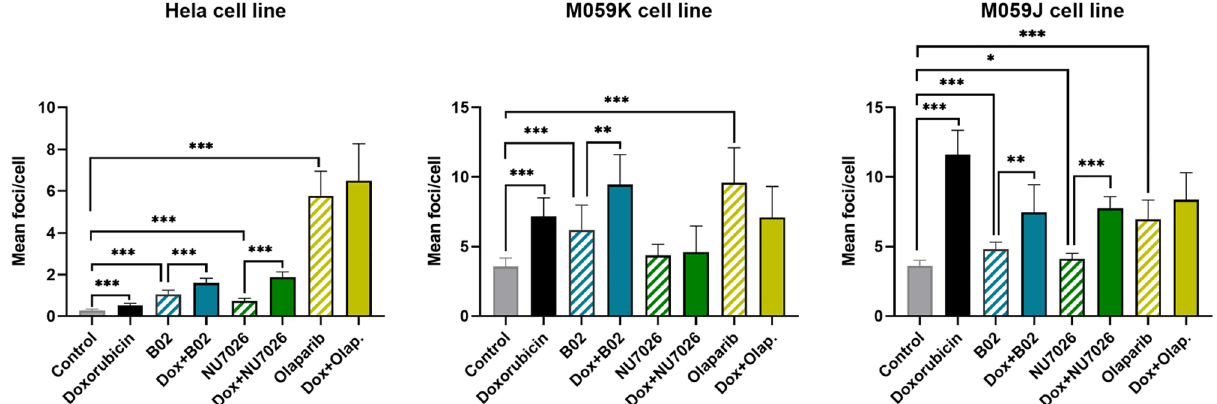
Figure 3. The 53BP1 foci in three cell lines after treatment with or without doxorubicin and/or DSB repair inhibitors. 53BP1 foci were measured in HeLa, M059K, and M059J cells after 48 h-treatment with doxorubicin at IC 10 combined or not with B02, NU702, and olaparib inhibitors at IC 50 . Three independent experiments were performed (n = 3) for the three cell lines (mean ± SD are depicted). *p < 0.05, **p < 0.01, ***p < 0.001 (Wilcoxon- Mann–Whitney test). Dox doxorubicin, Olap olaparib.